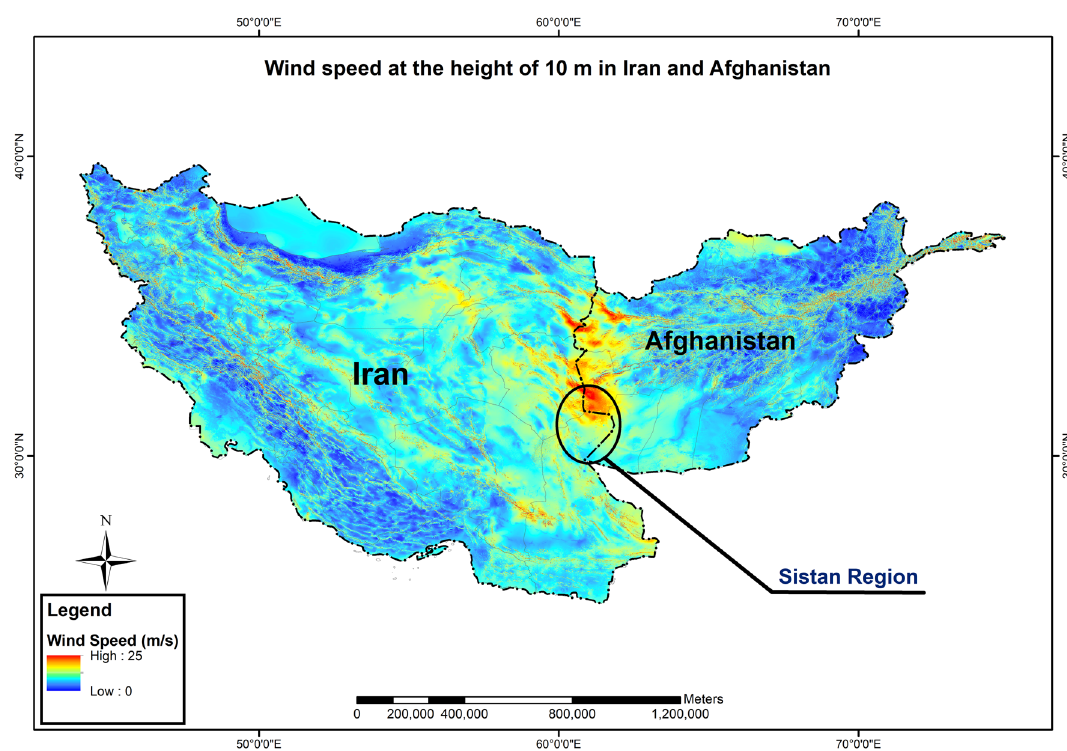
Figure 1. The highest wind speed occurring in the Sistan region 62 .